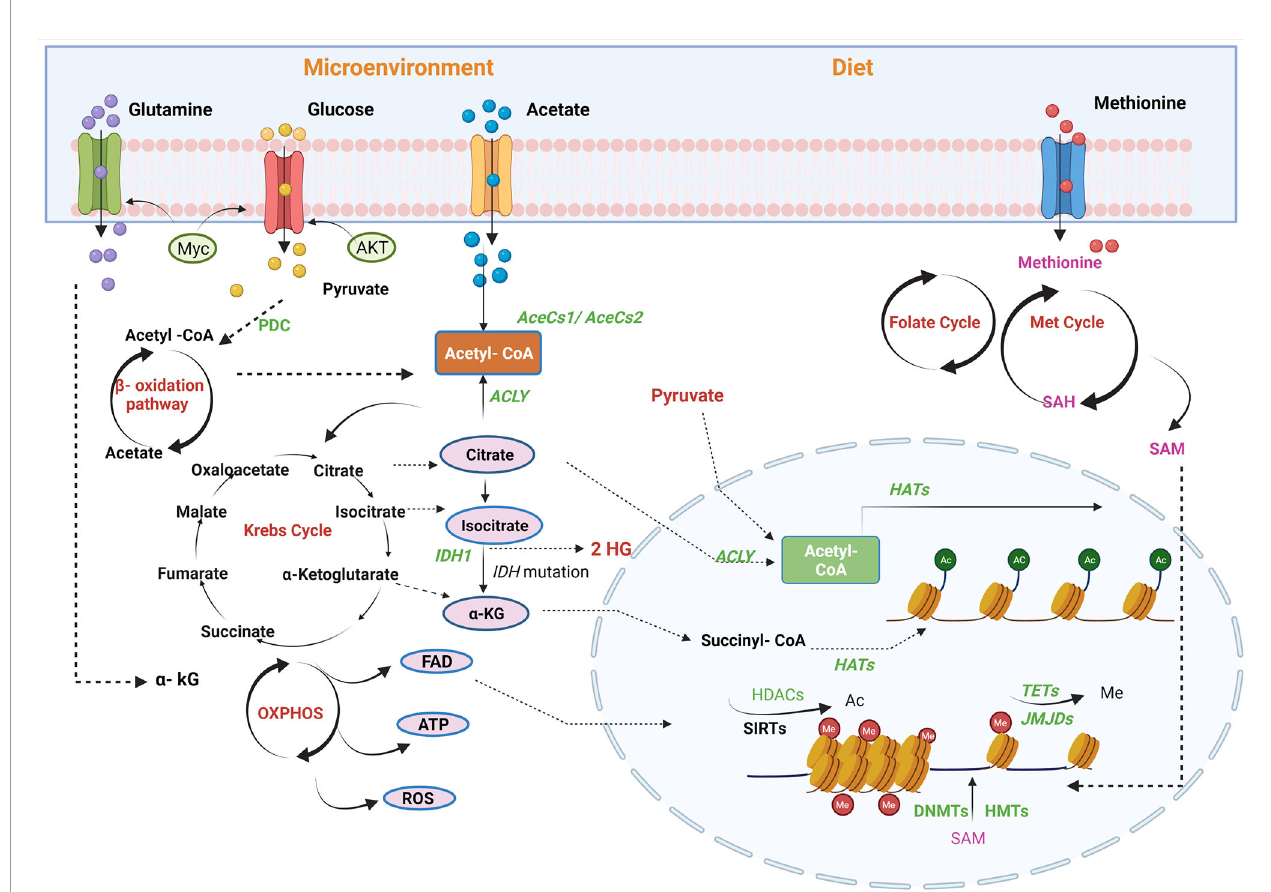
FIGURE 2 | Regulation of PCa epigenome by metabolic pathways. Metabolites are the mediators of epigenetic regulation through mitochondrial and nucleus crosstalk. Different factors contribute to epigenetic regulation, for example, microenvironment and availability of nutrients through diet. Acetyl-CoA, a connecting link between different metabolic pathways, provides acetyl groups in the cell, catalysed by histone acetyltransferases (HATs) for histone modi fi cations. In mitochondria, acetyl-CoA is generated via fatty acid oxidation, catalysis of pyruvate-by-pyruvate dehydrogenases complexes (PDC), and by utilising acetate by acyl-CoA synthetase short-chain family member 1/2 (AceSS1/AceSS1). Furthermore, TCA cycle metabolites, pyruvate, citrate, and acetate translocates into nucleus to generate acetyl-Co A pool by pyruvate dehydrogenase complex, ACLY and AceSS2, respectively. Another TCA cycle metabolite, a -ketoglutarate (KG), also translocates into the nucleus and is utilised by histone demethylases [Jumonji C domain-containing (JMJD)] and DNA demethylase [ten – eleven translocation (TET)]. In addition, isocitrate also diffuses into the cytosol and is converted to a -KG by isocitrate dehydrogenase enzyme. FADH2, a by-product of b -oxidation, is oxidised by electron transport chain into fl avin adenine dinucleotide (FAD), which translocates to the cytosol or nucleus. The amino acid cycles, namely, methionine and folate, generate an S-adenosyl methionine (SAM), a methyl group donor utilised by DNA methyltransferase (DNMT) and histone methyltransferases (HMTs). Acetyl-CoA, acetyl-coenzyme; ACLY, ATP-citrate lyase; SIRTs, sirtuins; TETs, ten – eleven translocation family; a -KG, alpha-ketoglutarate; HDAC, histone lysine deacetylase; DNMT, DNA methyltransferase; ATP, adenosine triphosphate; FAD, fl avin adenine dinucleotide; TCA, tricarboxylic acid; DNMT, DNA methyltransferase; JMJD, Jumonji C domain- containing histone demethylase. The fi gure has been created with